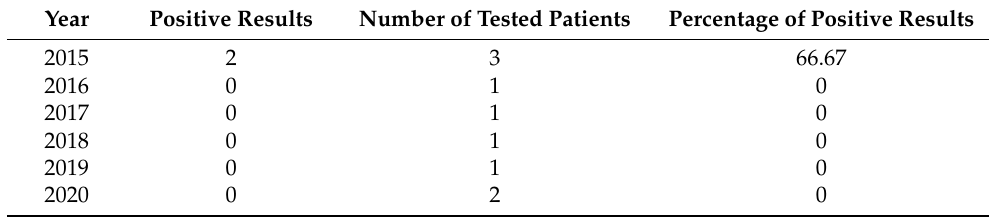
Table 15. Candida mannan antigen in NICU